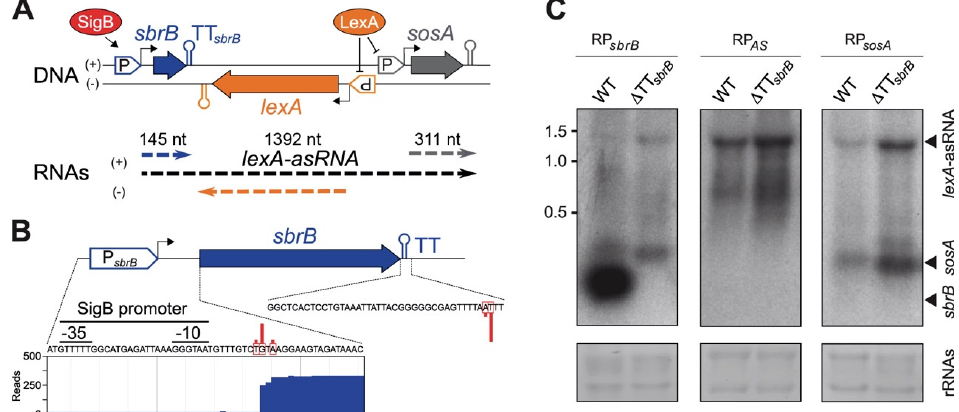
Figure 1. lexA -asRNA is produced from the SigB-dependent sbrB promoter upon transcriptional read-through of TT sbrB . ( A ) Schematic representation of the sbrB-lexA-sosA locus according previous transcriptomic maps [4]. ORFs and promoters (P) from sbrB , lexA and sosA genes are represented as blue, orange and gray arrows, respectively. Transcriptional terminators (TT) are illustrated as colored hairpins. Transcripts (RNAs) generated from both DNA strands are represented as dashed arrows. ( B ) Validation of sbrB mRNA boundaries. The transcriptional start and termination sites of the sbrB were determined by visualizing the S. aureus TSS sequencing data [30] and performing a simultaneous mapping of the 5 (cid:48) and 3 (cid:48) mRNA ends by circularization (mRACE) [31]. A Jbrowser image showing the RNA-Seq reads mapping on the sbrB promoter region is also included. The complete transcriptomic map is available at http://rnamaps.unavarra.es, accessed on 8 December 2021 [7]. Red bars represent the frequency of each nucleotide position at the 5 (cid:48) and 3 (cid:48) ends identified by mRACE. ( C ) Northern blots showing the sbrB , lexA -asRNA and sosA mRNA levels expressed from the S. aureus WT and ∆ TT sbrB strains. Transcripts were developed using 32 P-radiolabelled riboprobes designed to specif- ically target the sbrB (RP sbrB ), lexA -asRNA (RP AS ) and sosA (RP sosA ) mRNAs. The single-stranded transcript sizes from the RNA Millennium marker are indicated. Midori green-stained ribosomal RNAs are included as loading